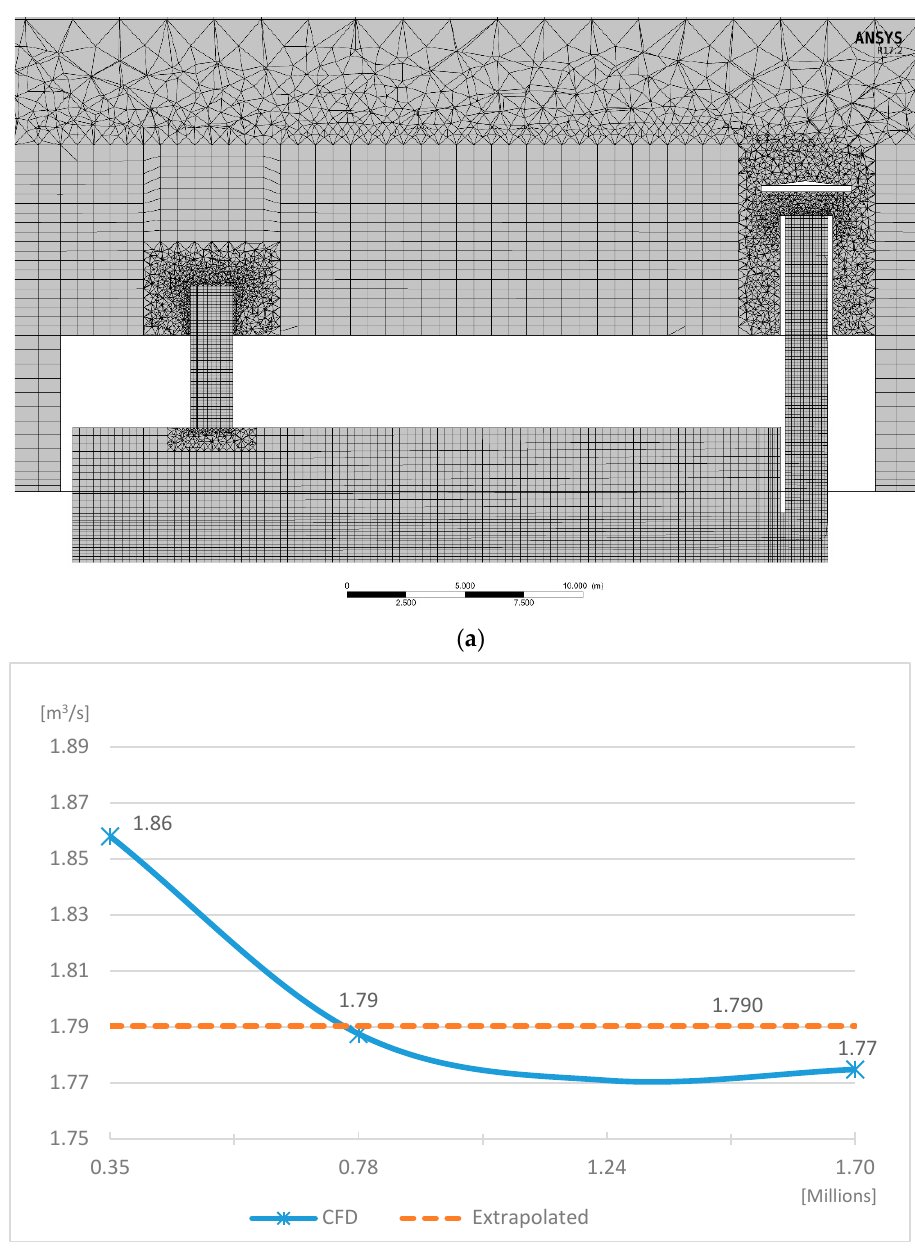
Figure 7. ( a ) he selected (medium) discretization (longitudinal section), and ( b ) the grid independency test’s ACH [m 3 /h] results.